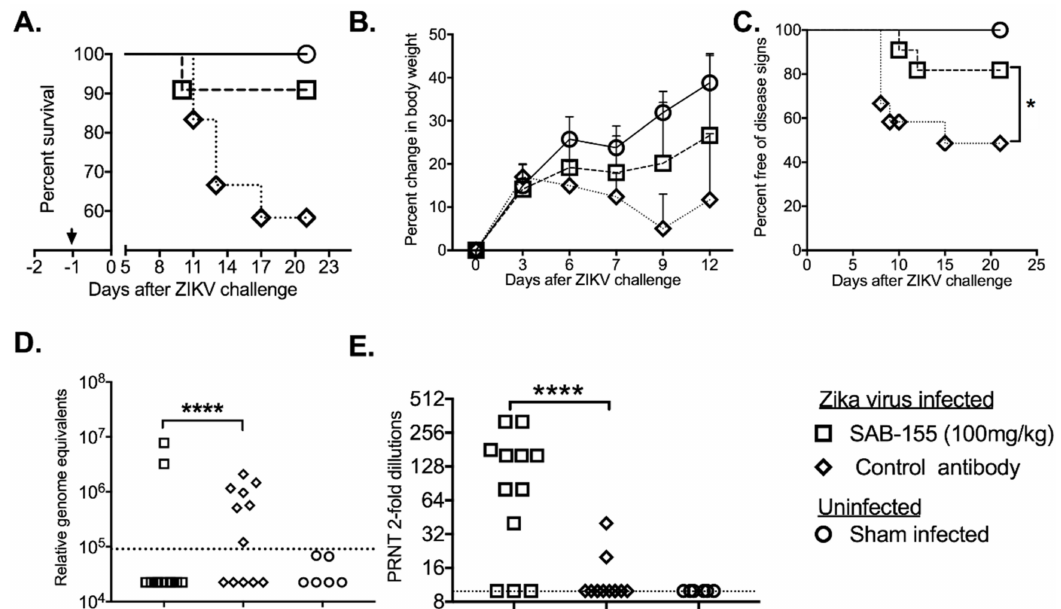
Figure 2. Prophylactic i.p. administration of SAB-155 to ZIKV infected STAT2 KO hamsters. Equal numbers of male ( n = 6) and female ( n = 6) s.c. infected with PRVABC69 ZIKV. Sham infected controls had three each from both sexes. ( A ) Survival, arrowhead indicates treatment as one day before viral challenge ( − 1); ( B ) daily percent changes in the weights of surviving animals relative to the day of virus challenge; ( C ) percent free of eye disease, conjunctivitis; ( D ) Presence of ZIKV RNA in serum at 3 dpi. (E) Serum PRNT from serum of animals as in ( D ). *, p < 0.05; unpaired t -test; ****, p < 0.0001 by one-way ANOVA compared between SAB-155 vs. negative control antibody treatment. Dashed lines designate limit of detection in Figure